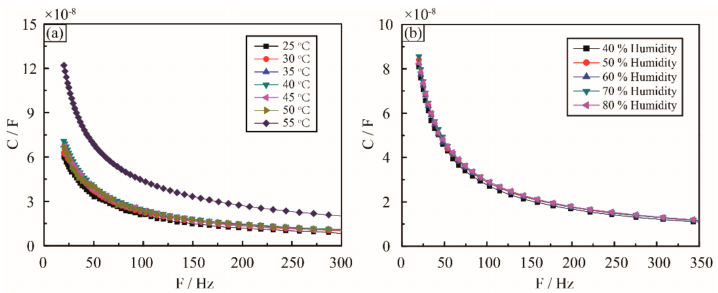
Figure 5. Effect of the environment factors. ( a ) Capacitance change with frequency at temperature range from 25 ◦ C to 55 ◦ C. ( b ) Capacitance follows the frequency at humidity range from 40% to